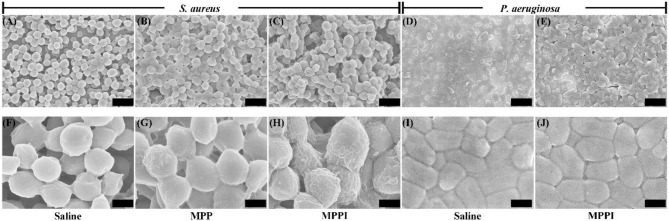
Representative scanning electron microscopy (SEM) images of S. aureus biofilms after 6 h incubation with saline (A,F), MPP NSs (B,G, MoS2: 160 μg/mL), and MPPI NSs (C,H, MoS2: 160 μg/mL) and P. aeruginosa biofilms with saline (D,I) and MPPI NSs (E,J, MoS2: 160 μg/mL). The scale bars represent 2 μm in (A–E) and 500 nm in (F–J).